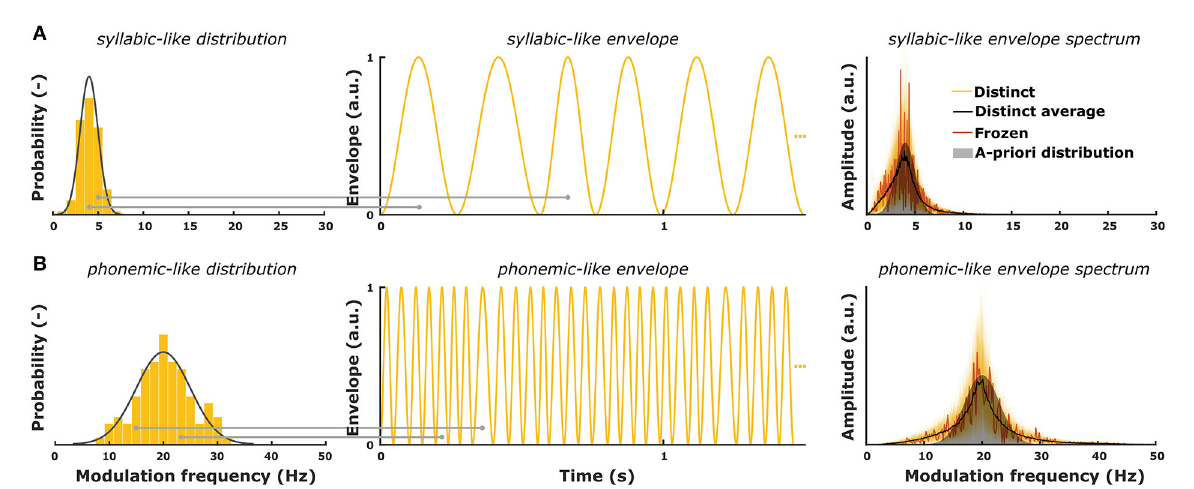
FIGURE1 (A) A-priori modulation frequency distribution for syllabic-like envelopes (mean = 4Hz; standard deviation = 1Hz) and an exemplary envelope. The right panel shows modulation spectra of 200 syllabic-like TEMPEST envelopes (yellow) along with the averaged distinct spectrum (black) and the spectrum of the frozen envelope (red). (B) A-priori modulation frequency distribution for phonemic-like envelopes (mean = 20Hz; standard deviation = 3Hz) and an exemplary envelope. The right panel shows modulation spectra of 200 phonemic-like TEMPEST envelopes (yellow) along with the averaged distinct spectrum (black) and the spectrum of the frozen envelope (red). Histograms show the sampled modulation frequencies of the exemplary envelopes. Horizontal gray lines depict the sampling of modulation frequency for two envelope windows with corresponding window length ( = 1/f m